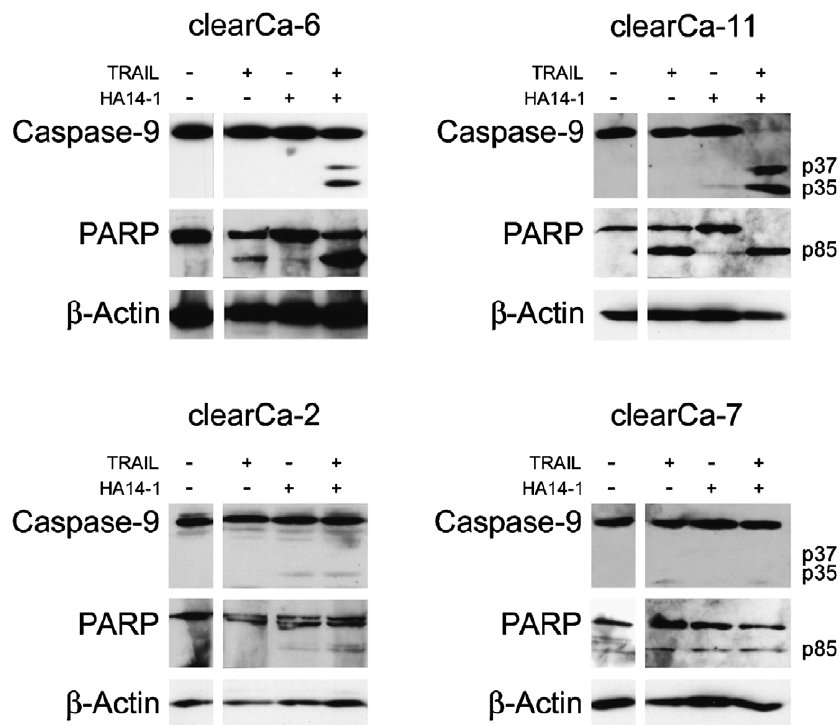
Fig. 7. Western Blot analysis of caspase-9- and PARP-cleavage after combined exposure to HA14-1 and TRAIL. Strong caspase-9 and PARP-cleavage in the TRAIL-sensitive cell lines clearCa-6 and clearCa-11 after combined treatment with TRAIL (100 ng) and HA14-1 (25 µg) after 12 h as markers for synergistic activation of the mitochondrial pathway of apoptosis. No cleavage of PARP and caspase-9 in the resistant cell lines clearCa-2 and clearCa-7 after combined treatment with TRAIL (100 ng/ml) and HA14-1 (25 µM) after 12